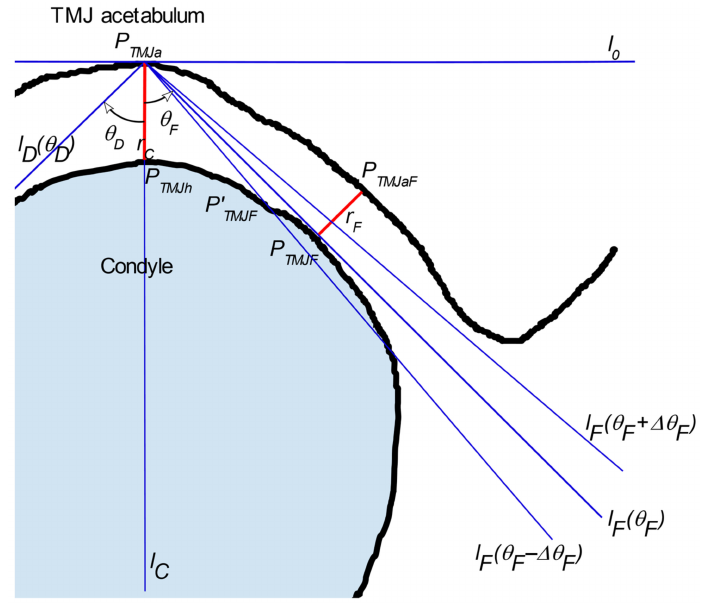
Figure 7. Determination of the line tangent to the TMJ head.